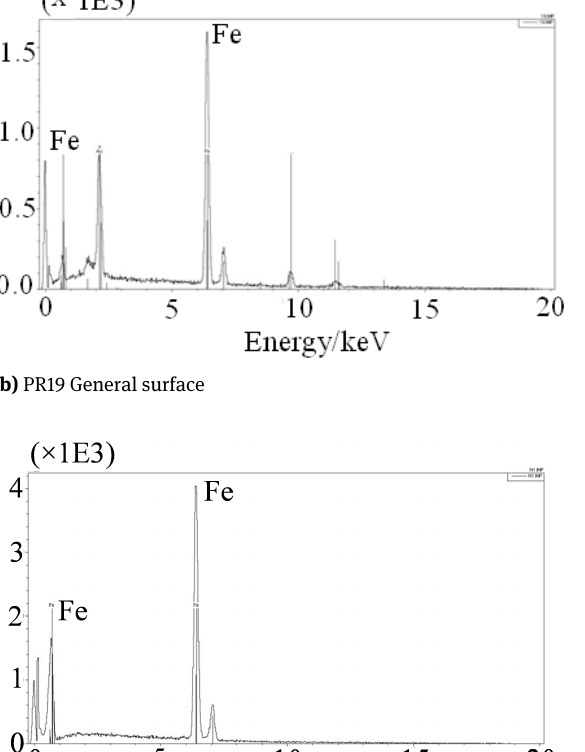
Figure 9: EDS result of nail samples.